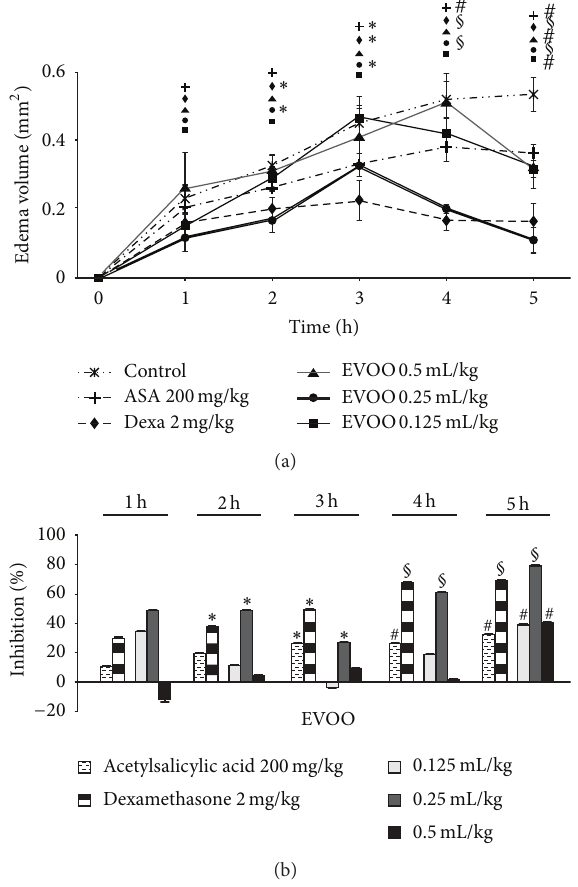
Figure 2: Anti-inflammatory effect of extra virgin olive oil. (a) Time course of the carrageenan-induced rat hind paw edema volume after intraplantar injection of acetylsalicylic acid (200 mg/kg), dexam- ethasone (2mg/kg) and extra virgin olive oil (resp. 0.125, 0.25, and 0.5 mL/kg). Dexamethasone and acetylsalicylic acid were used as reference agents while saline was used as control. (b) Percentage of carrageenan-induced edema inhibition by extra virgin olive oil and reference agents as compared to saline-treated rats. Results are reported as means ± SD. ∗ 𝑃 < 0.05 , # 𝑃 < 0.01 , and § 𝑃 < 0.001 (two-tailed Student’s 𝑡 -test), as compared to saline-treated rats.